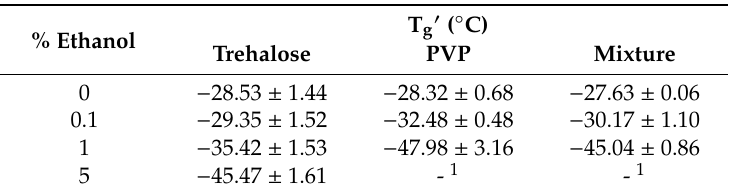
Table 4. Glass transition of the freeze-concentrated (T g (cid:48) ) solution of trehalose, PVP, and the combination thereof in the presence of di ff erent ethanol